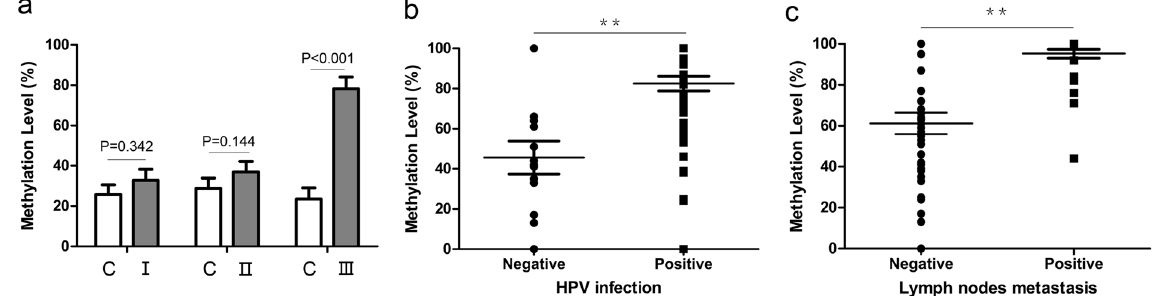
Figure 3. The correlation between MEG3 promoter methylation and clinical pathological characteristics of cervical cancer patients. ( a ) The methylation level of MEG3 promoter in CIN I (I), CIN II (II) and CIN III (III) patients’ plasmas. The methylation level of MEG3 promoter was significantly higher in HR-HPV positive ( b ), and lymph node metastasis ( c ) patients’ plasmas, compared with their controls respectively. C, control. ** P <